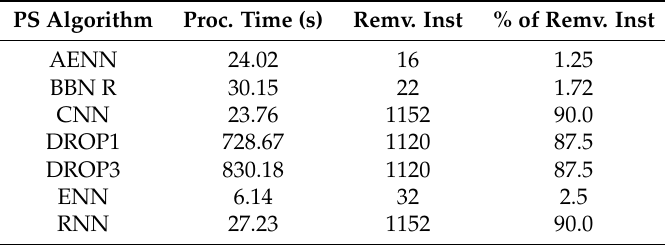
Table 2. Prototype selection algorithms analysis.